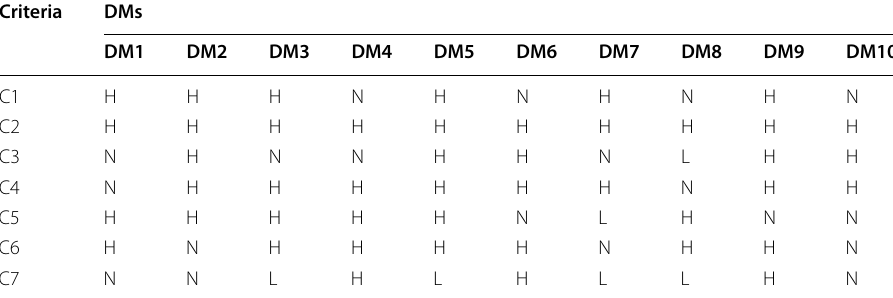
Table 4 Linguistic evaluation of the criteria by the DMs Criteria